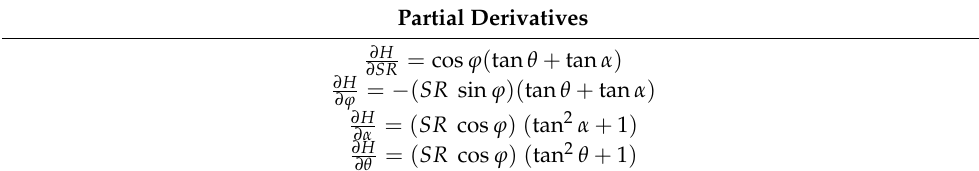
Table 2. Partial derivatives involved in Equation